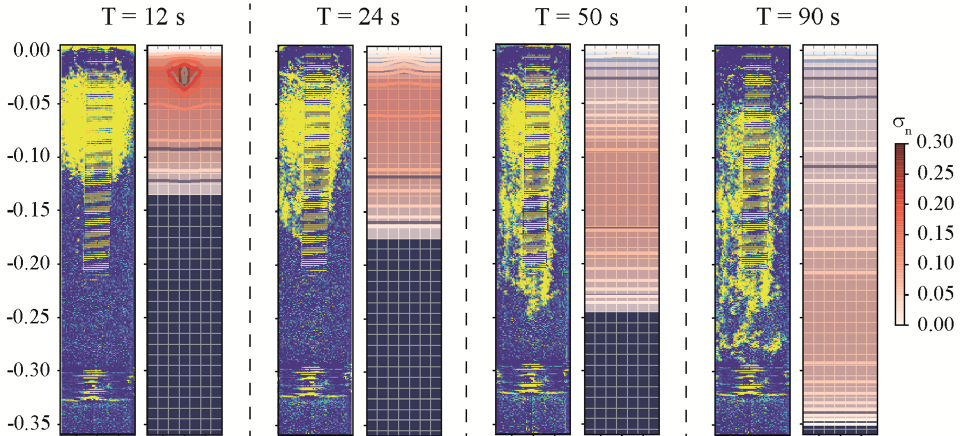
Figure 5. Comparison between the experimental results on the DNAPL migration in a column and three-dimensional numerical results on the saturation contours ( σ n = S n φ ) of the DNAPL in a column using a grid dimension of 0.060 m × 0.060 × 0.360 m, at different times: 12 s, 24 s, 50 s, 90 s. The left-hand side of each panel time shows the experimental result, while the saturation contours of the DNAPL migration in the ( z − x ) plane are placed on the right-hand side of each panel. The first panel shows the time at 12 s, the second at 24 s, the third at 50 s, and the fourth at 90 s, respectively. The contaminant is released for three seconds with a pressure of 4118.0 Pa. Then, it moves downward (no hydraulic gradient is present), but lateral spreading also occurs due to the effect of the viscosity/capillary pressures (see Table 1 for details). Notice how the contaminant fills the entire column at each time.